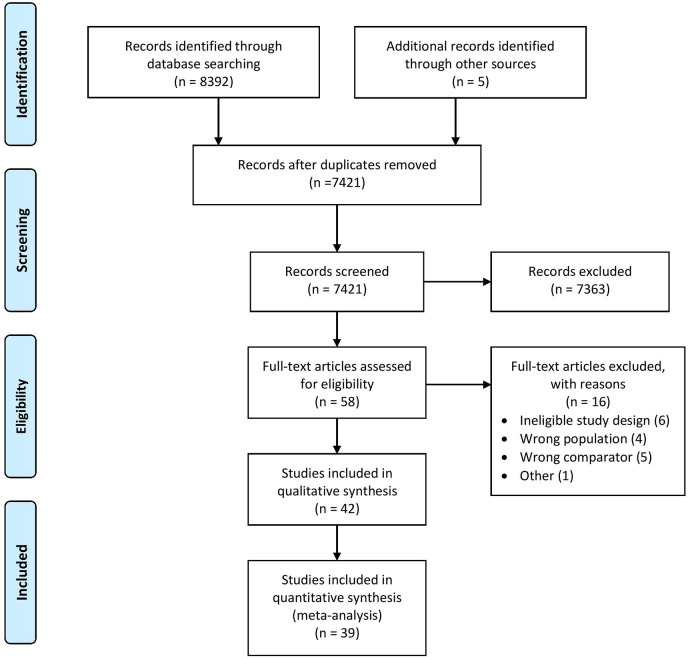
PRISMA flowchart.